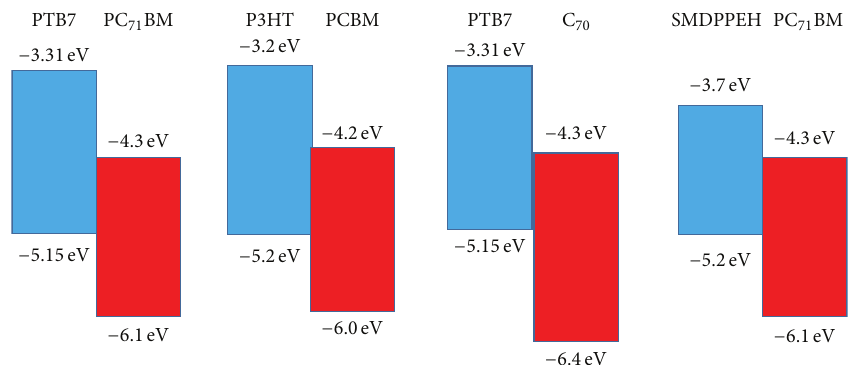
Figure 3: Energy level diagrams of various D/A